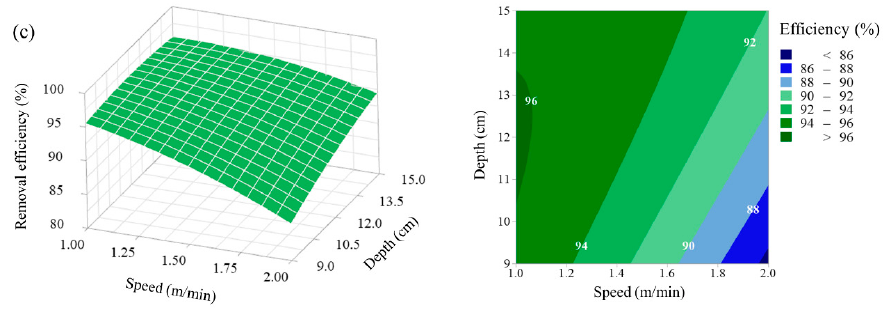
Figure 2. Response surface plots presenting the interaction effects of three variables on the total nematode removal efficiency: ( a ) surface plot showing the effect of the steam temperature and running speed on the removal efficiency, ( b ) surface plot showing the effect of the steam temperature and spray depth on the removal efficiency, and ( c ) surface plot showing the effect of the running speed and spray depth on the removal efficiency.